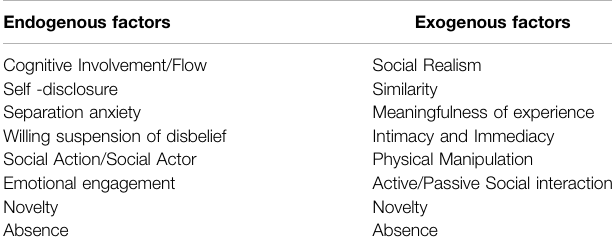
TABLE 2 | Endogenous and exogenous factors of social